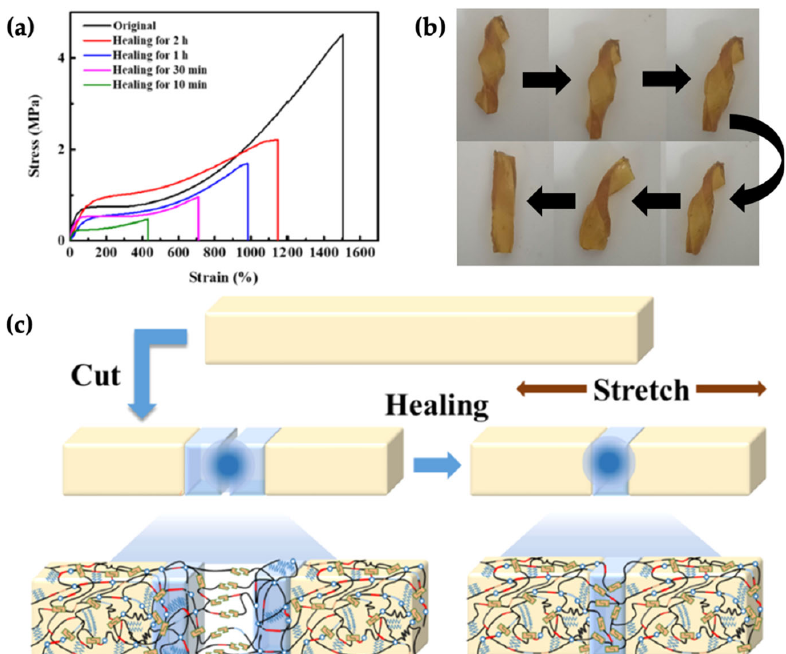
Figure 8. The shape memory with self-healing in biomass bifunctional polyamide elastomers (BbPEs); ( a ) stress–strain curves of BbPEs with various healing times, ( b ) shape memory process of BbPE sample, and ( c ) schematic illustration of the healing process of BbPEs [55]. Adapted with permission from [55]. Copyright 2021 American Chemical Society.